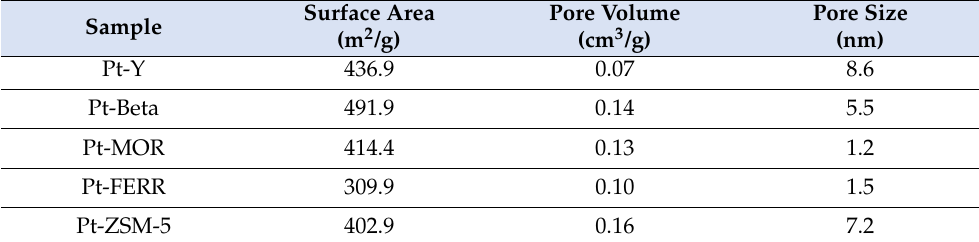
Table 3. The texture properties of the prepared samples as determined using N 2 sorption analysis technique.